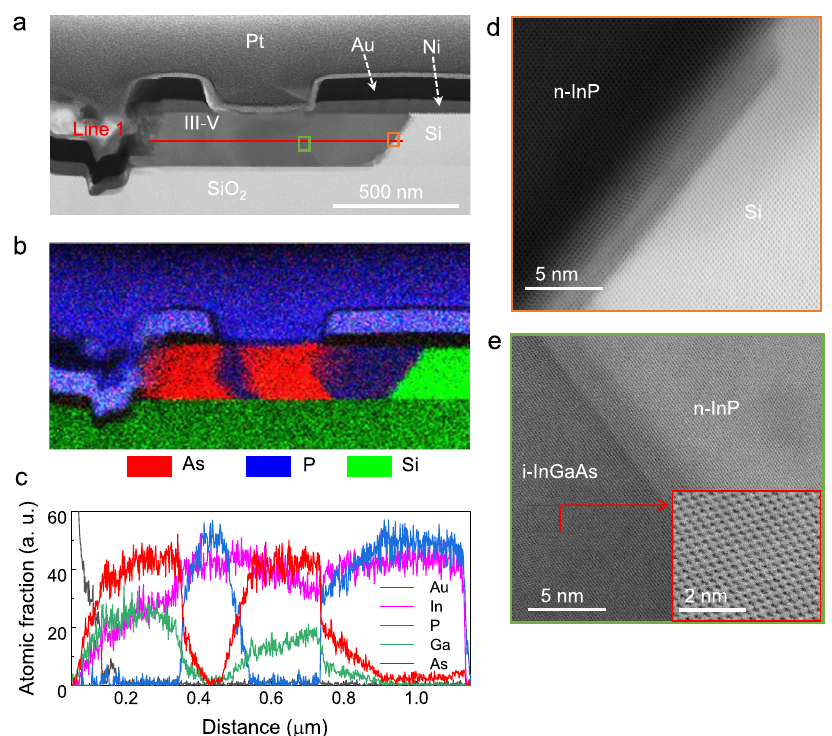
Fig. 2 Nanostructure of p-i-n device and EDS analysis. a Bright fi eld scanning transmission electron microscopy (STEM) cross-section overview image of a 350 nm straight device. b Energy dispersive spectroscopy (EDS) overview map of the p-i-n device. Here, P, Pt, and Au appear blue because the EDS signal of P K-shell is near to the Pt and Au M-shell. c EDS elemental pro fi les acquired along Line 1 de fi ned in a . d High-resolution bright fi eld scanning transmission electron microscopy (STEM) images taken at Si/n-InP interface (orange box marked in a ). e High-resolution bright fi eld STEM images taken at n-InP/i-InGaAs interface (green box marked in a ), inset: high-resolution STEM of the